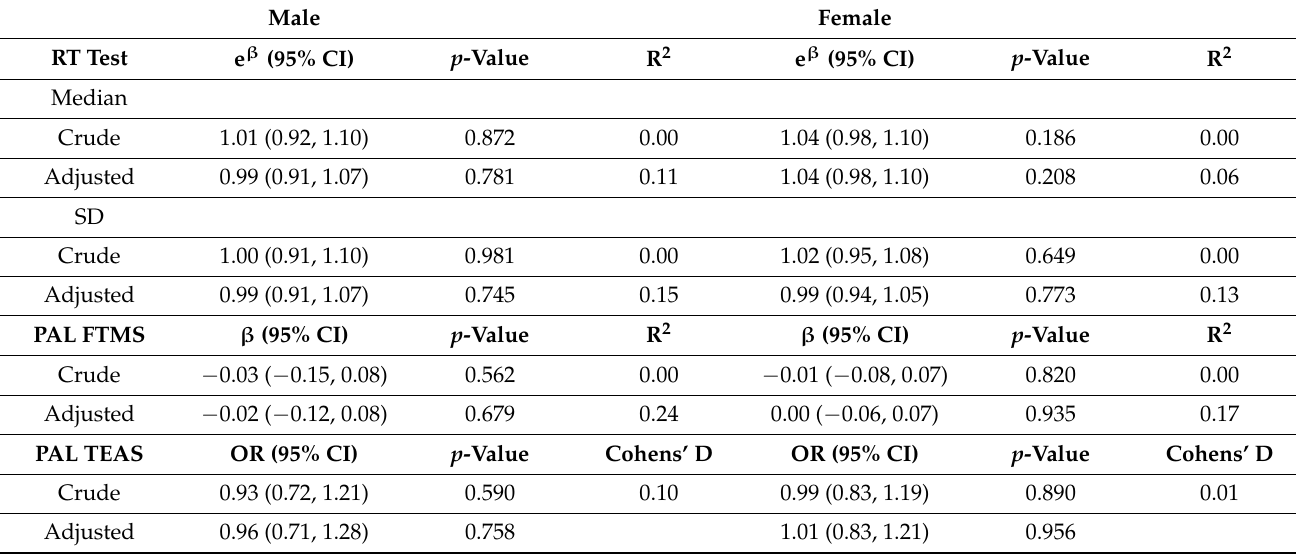
Table 6. Association of hazardous drinking PGS with RT test and PAL test in male and female bipolar disorder patients. Male